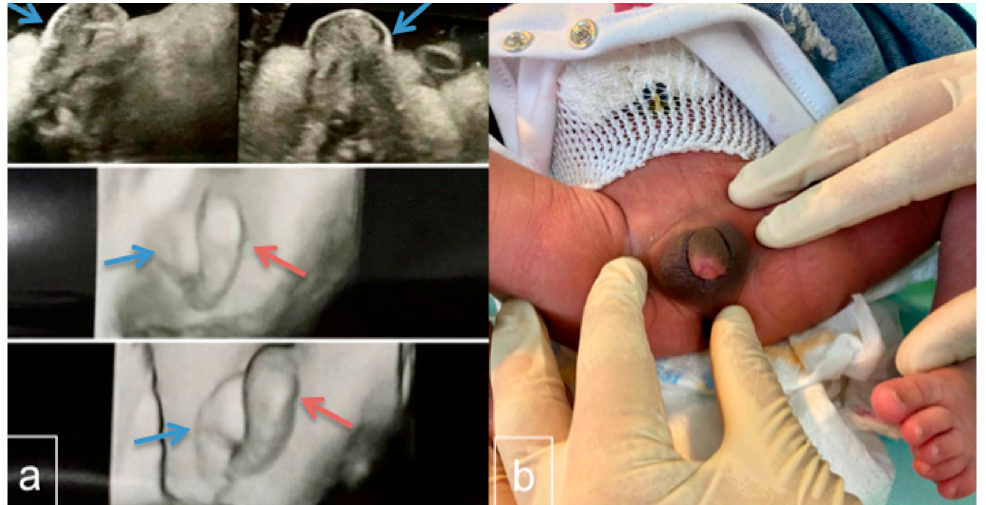
Figure 1. ( a ) Ultrasound scan, 2D and 3D, of the fetal genitalia done in the second trimester. Visualization of the vulva, clitoris, and labia is considered to indicate a female fetus whereas demonstration of the scrotum, penis, descended testicles, and penile midline raphe is interpreted as indicative of a male. In the ultrasound image, there is a labial/scrotum-like formation (blue arrow) and a median prominence similar to the phallus/clitoris (red arrow). ( b ) Infant 24 h after birth with ambiguous genitalia. The phallus was 1.4 cm in length with a blind dimple on the glans and a urethra that opened ventrally at the base, consistent with Prader 4 hypospadias. The clitoral index was 0.7. The anogenital ratio was 0.78. No gonads were palpable in the labial/scrotal tissue. Pelvic imaging did not identify a uterus or ovary, but only small formations in the inguinal duct.